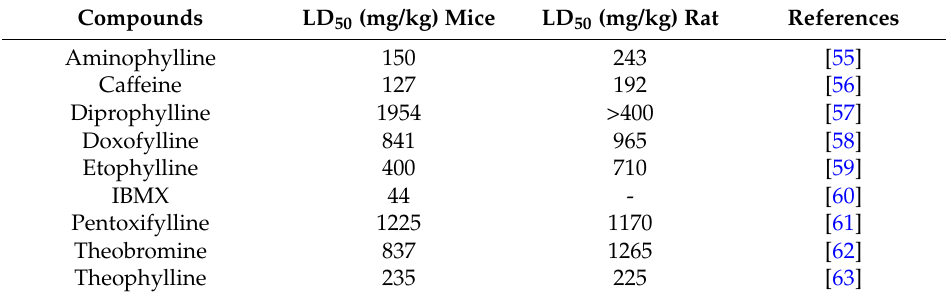
Table 4. LD 50 values of methylxanthine compounds in mice and rat available in literature and the respective source of